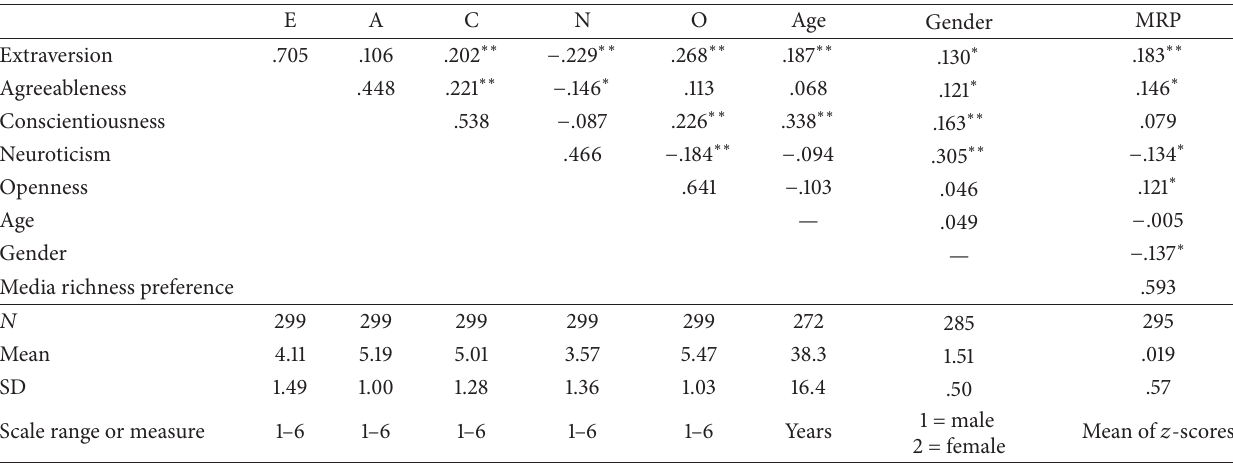
Table 2: Descriptive statistics and bivariate